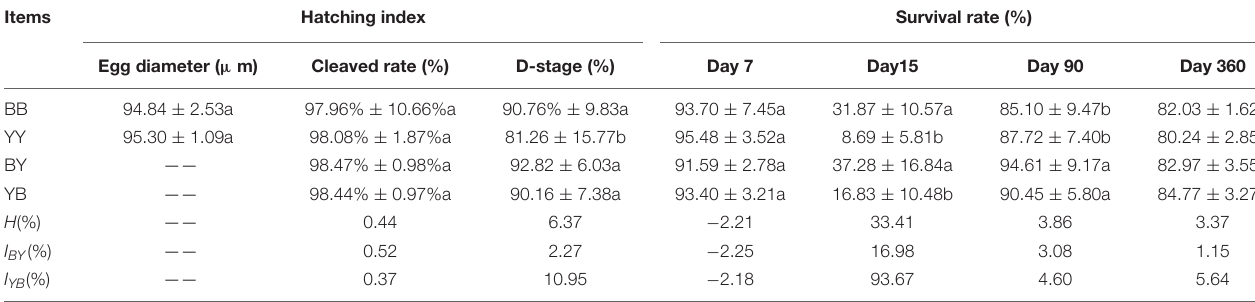
TABLE 2 | Hatching index, survival ability and metamorphism of two strain’s progeny (BB and YY) and their reciprocal hybrids (BY and YB), as well as heterosis ( H and I ). Items